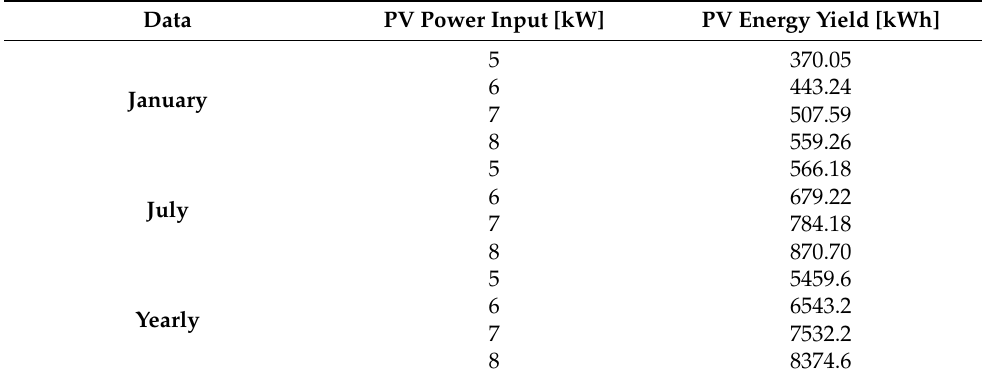
Table 2. Table 2. PV Sources energy Table 2. PV Sources energy yield.